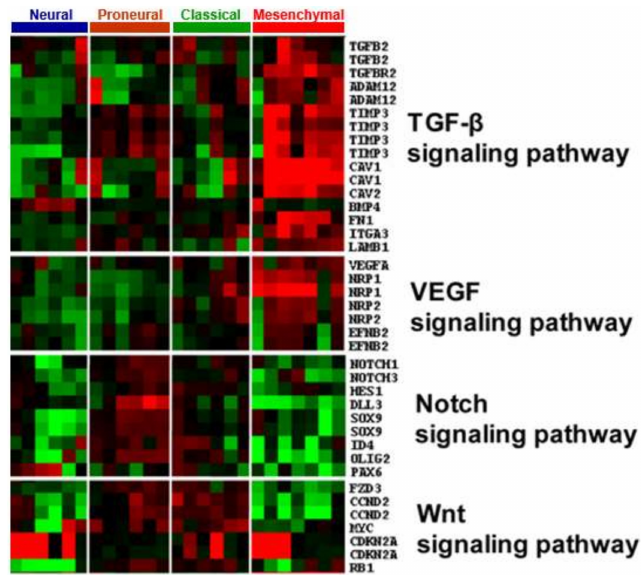
Figure 6. GIC subtypes exhibited divergent patterns of signaling pathway activation. Multiple pathways, such as TGF- β , Notch, VEGF, and Wnt, were identified in GIC